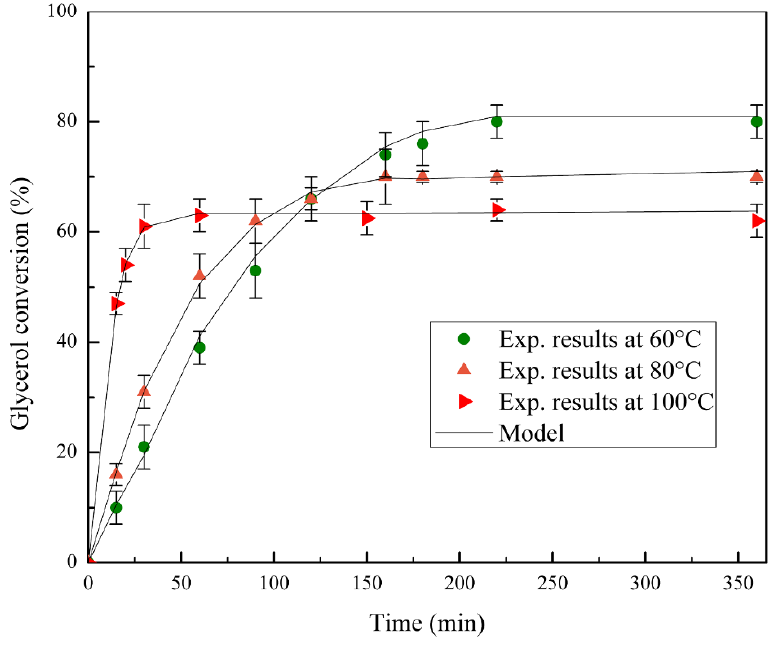
Figure 6. Glycerol conversion vs. time at different temperatures. Reaction conditions: A/G = 6, m cat = 0.25% wt. The bars indicate the standard deviation of each point.